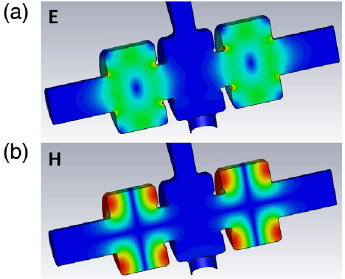
2.1 GHz warm cavity: (a) E field in the cross section; (b) H field in the cross